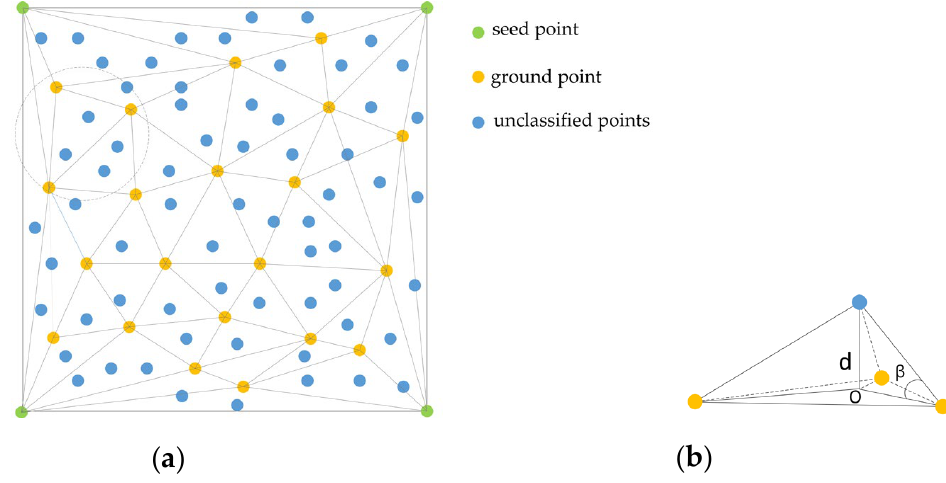
Figure 3. Determine whether an unclassified point is a ground point [32]. As some ground points may be lower than the plane of an identified ground triangle, the progressive TIN densification filtering may omit these ground points. In this paper, for a point in a triangle area, if its distance to the triangle is less than a pre-set threshold r , it is identified as a ground point, as shown in Figure 4. The extracted ground point clouds are used to generate a digital elevation model (DEM) by interpolation, then the other part of the point cloud (non-ground point) is normalized according to the DEM, to obtain the elevation features of the point clouds, which could help eliminate the influence of terrain undulation on the